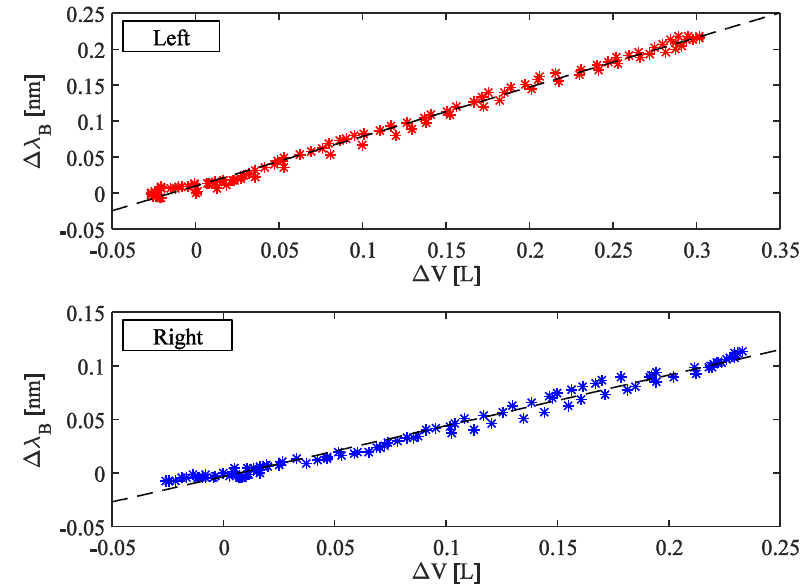
Figure 5. Correlation between the FBGs wavelength changes and UT volume considering both left and right side. The best fitting lines are also shown.